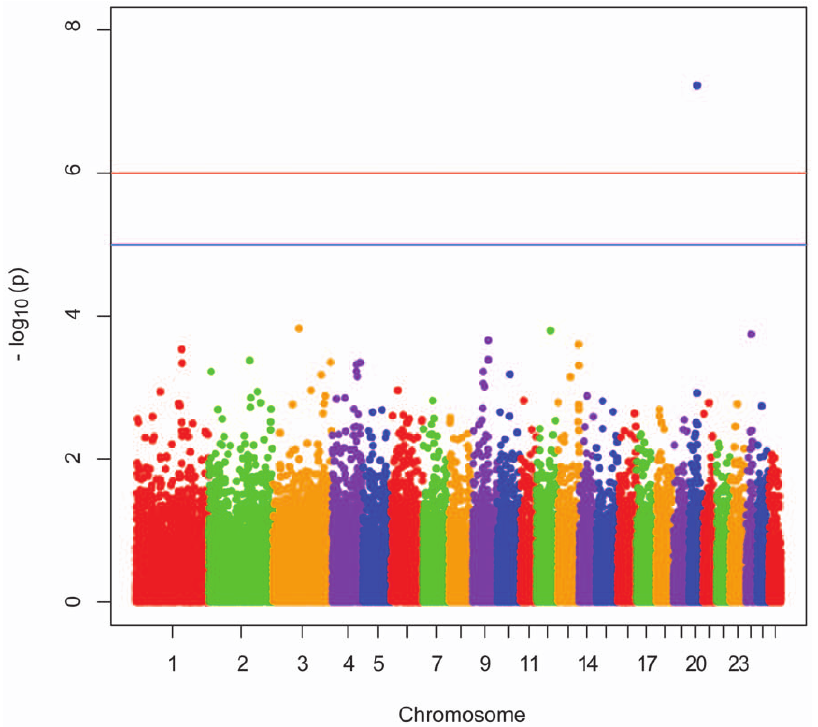
Figure 2. Manhattan plot for control of OvLV infection. The Manhattan plot shows nominal P-values from association with proviral concentration by chromosomal position. Representative data from the Rambouillet, dominant mode of inheritance analysis are shown. The top red line shows a genome-wide significance threshold defined by nominal P-values of 1x10 -6 , which is P=0.05/50,000. The lower blue line shows a genome-wide suggestive significance threshold defined by nominal P-values of 1x10 -5 .